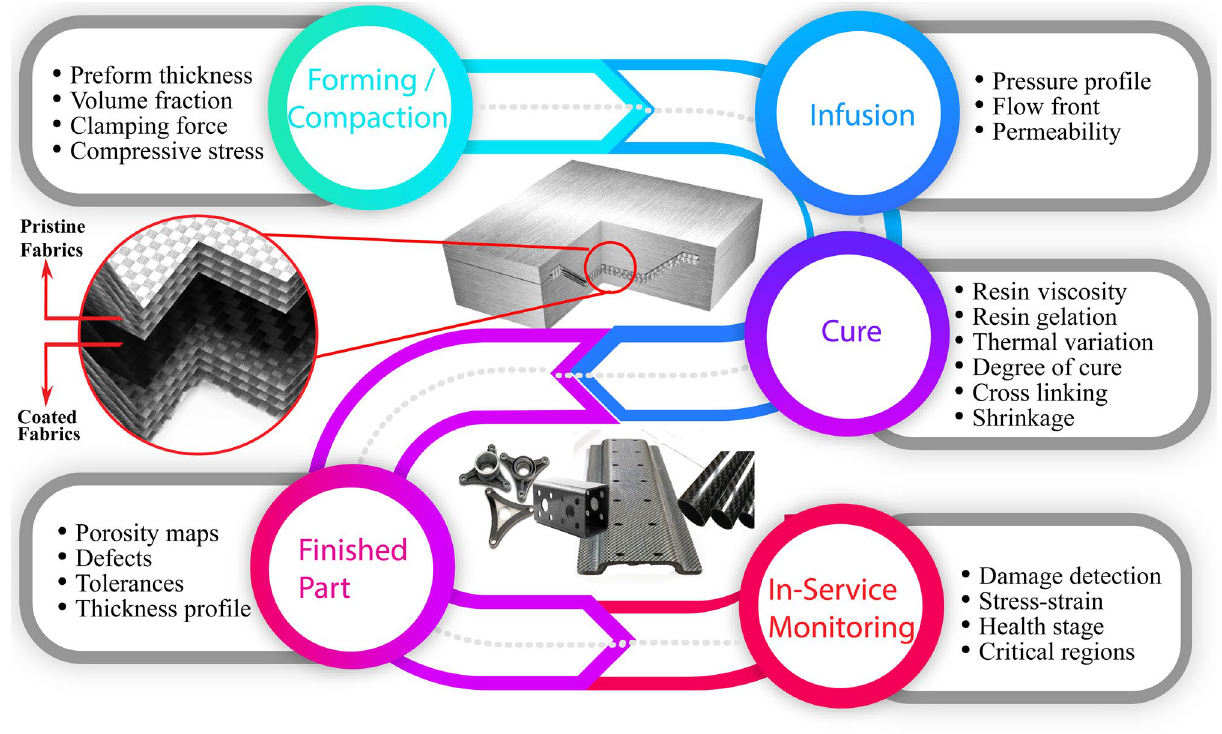
Figure 2. Data generated during the life cycle of a smart composite component, during and after manufacturing. Fabric compressibility is quantified by the applied stress required to achieve the target fiber volume fraction. The evolution of reinforcement permeability and flow characteristics are the important characteristics during the resin infusion followed by the cure kinetics of the resin. The distribution of stress within a structure is crucial for monitoring its health and for adopting prognostic measures. All aspects being monitored using in-situ coated